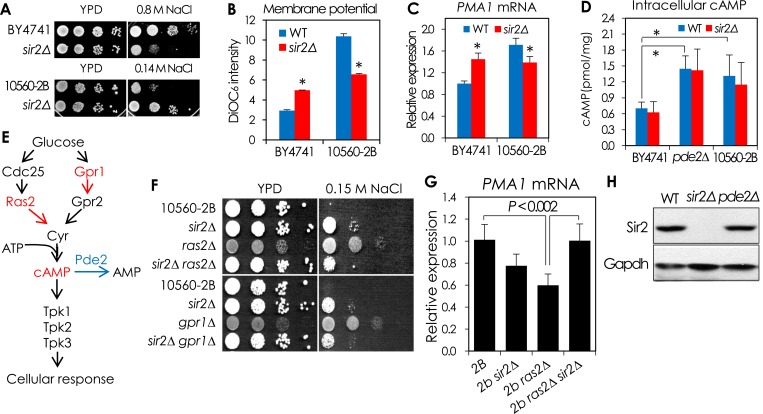
The cAMP-PKA signaling-dependent effects of SIR2 deletion on NaCl sensitivity and PMA1 expression.(A–D) The effect of SIR2 deletion on NaCl sensitivity and PMA1 expression in a sigma background 10560-2B strain is opposite to that in BY4741. The 10560-2B strain has hyperactive cAMP-PKA pathway, which confers an increased NaCl sensitivity to the strain. (A) NaCl sensitivity of WT and sir2∆ in BY4741 and 10560-2B. (B) Plasma membrane potential of WT and sir2∆ in BY4741 and 10560-2B (*, vs WT in an indicated strain, p < 0.005). (C) PMA1 mRNA levels of WT and sir2∆ in BY4741 and 10560-2B measured by qRT-PCR (*, vs WT in an indicated strain, p < 0.0001). (D) Intracellular cAMP levels of WT and sir2∆ in BY4741, BY4741 pde2∆ and 10560-2B (*p < 0.005). (E–H) Reduction of cAMP/PKA signaling reversed the effect of SIR2 deletion on the PMA1 expression in 10560-2B strain. (E) Overview of the cAMP/PKA signaling pathway. (F) Effect of deleting either RAS2 or GPR1, encoding an activator of adenylate cyclase or a G-protein glucose receptor, on the NaCl sensitivity of WT 10560-2B and sir2∆ cells. (G) The PMA1 mRNA levels of WT 10560-2B, sir2∆, ras2∆, and sir2∆ ras2∆ cells were analyzed by qRT-PCR. (H) Sir2 protein levels in WT and pde2∆ cells measured by WB. GAPDH protein was used as a loading control.